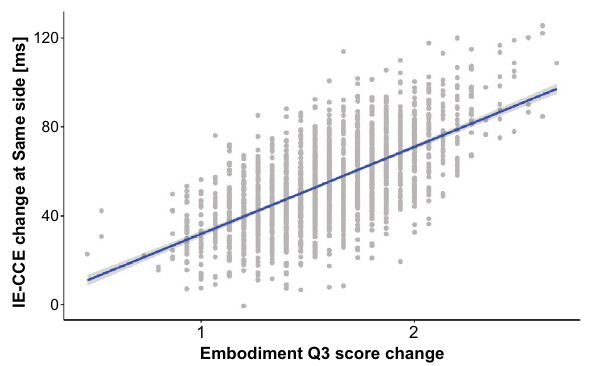
Figure 5. Correlation between the change in IE-CCE under the same-side condition and the change in response to the embodiment score Q3 before and after learning. Dots indicate points resampled by the bootstrap method, and linearly approximated lines and 95% confidence intervals are shown as the shadows of the regression lines.